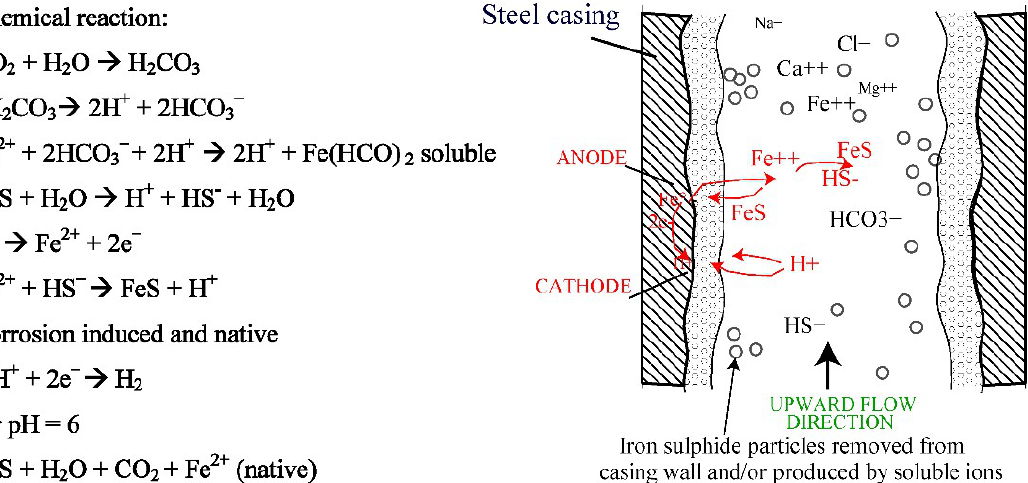
Figure 2. Schematic illustration of the process of iron dissolution and sulfide precipitation in a CO 2 /H 2 S aqueous system (modified from [29]).